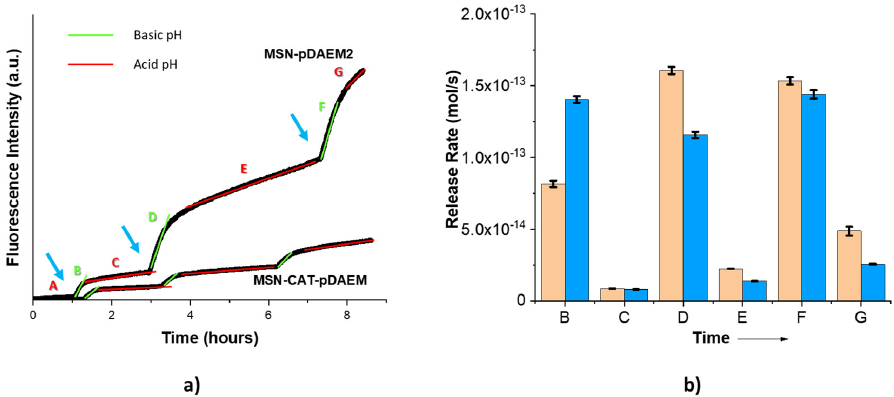
Figure 7. ( a ) Fluorescence intensity of SRB released from SRB-loaded MSNpDAEM2 and MSN-CAT-pDAEM (solid black lines), diffusing across the dialysis membrane (measured in the bottom compartment of the cuvette in PBS). The system is followed continuously for 8.3 h ( λ exc = 566 nm, λ em = 589 nm). The blue arrows indicate additions of base solution in the top compartment of the cuvette, green lines (zones B, D, and F), and red lines (zones C, E, and G) indicate basic and acid pH periods, respectively. ( b ) Cargo release from MSN-pDAEM2 (orange columns) and MSN-CAT-pDAEM (blue columns); B–H indicate the time intervals shown in ( a ). Time interval A corresponds to the desorption of SRB remaining at (or close to) the particle surface after the cleaning procedure.